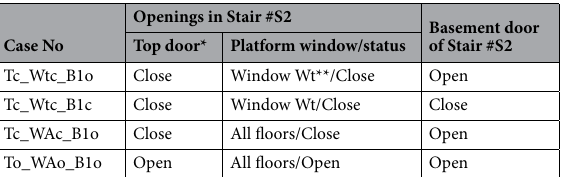
Table 5. Symbolic description of the simulation cases. *Top door of the 2nd stair. **Platform window number is shown in Fig. 8A.